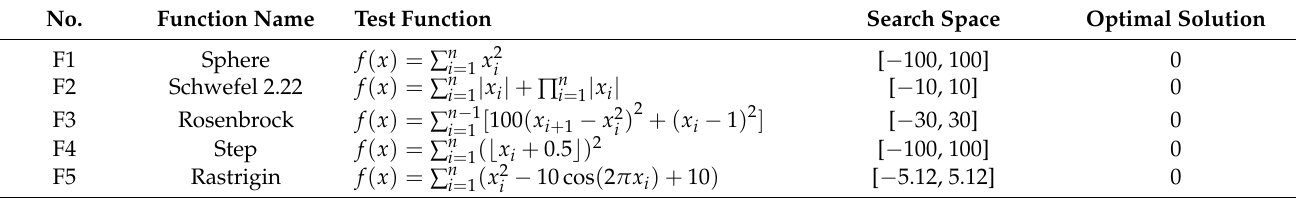
Table 5. Five kinds of test functions for function extreme value optimization. Search Space Optimal